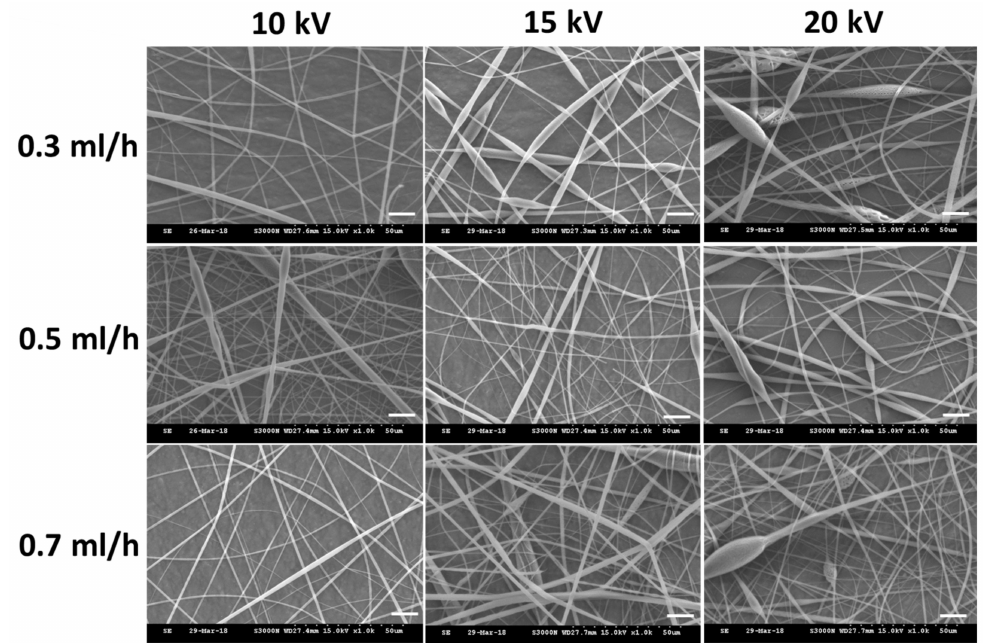
Figure2. Thescanningelectronmicroscope(SEM)imagesoftheelectrospunpolylacticacid / docosahexaenoic acid (PLA / DHA) core-shell nanofibers fabricated under di ff erent voltage (in kV) and core solution flow rate (in mL /